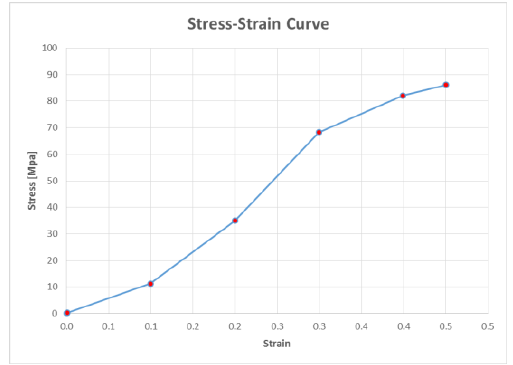
Figure 5. Stress–strain curve of the woven